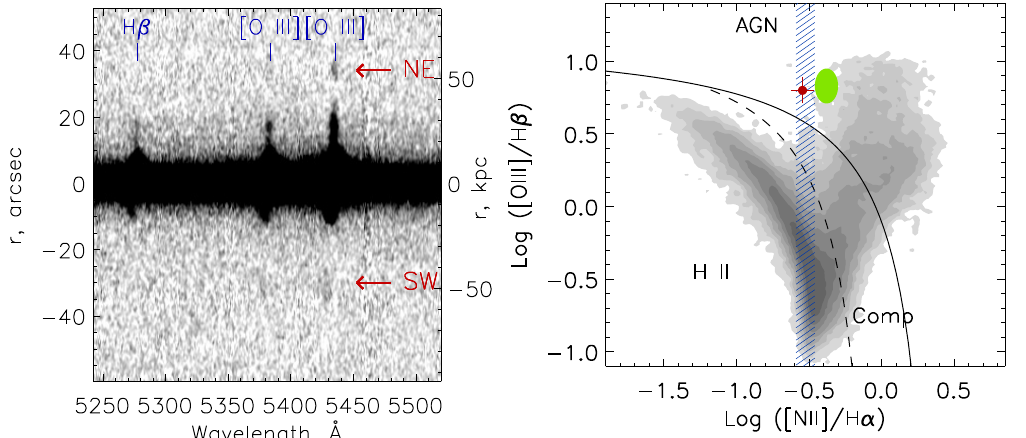
Figure 4. Ionized gas in the Teacup giant EELR. Left : a fragment of the 2D SCORPIO-2 spectrum along PA = 60 ◦ around the H β +[O III ] λλ 4959,5007 region. The red arrows mark the NE and WS Arcs. Right : a BPT diagram similar to one the presented in Figure 3 [13]. The gray contours represent the density distribution of the SDSS galaxies line ratios based on the data from Kewley et al. [28]. The division lines between the star-forming galaxies, AGN, and composite nucleus are taken from Kewley et al. [29], Kauffmann et al. [30]. The vertical blue shadowed area represents the range of values measured for the giant nebula at GTC [13]. The green filled ellipse shows the line ratios measured by Gagne et al. [11] for the areanearest the AGN regions ( r < 15 kpc). The red point corresponds to both our SCOPRIO-2 ( I ([OIII] λ 5007)/ I (H β )) and GTC ( I ([NII])/ I (H α )) measurements for the distances r = 19–41